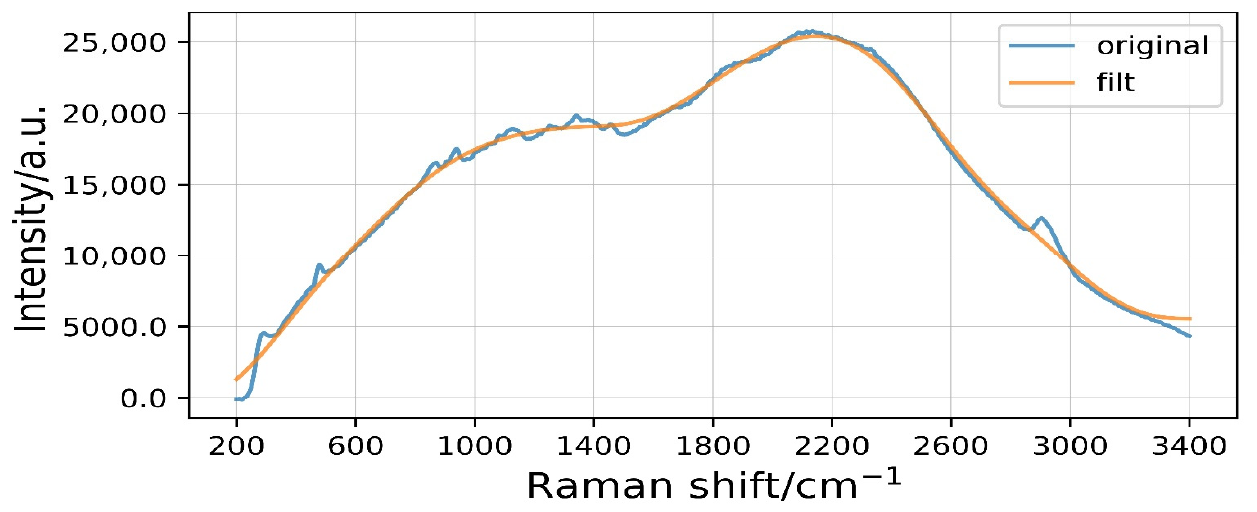
Figure 2. Comparison between filtering curve and original curve. Blue line is original curve, orange line is filtering curve.